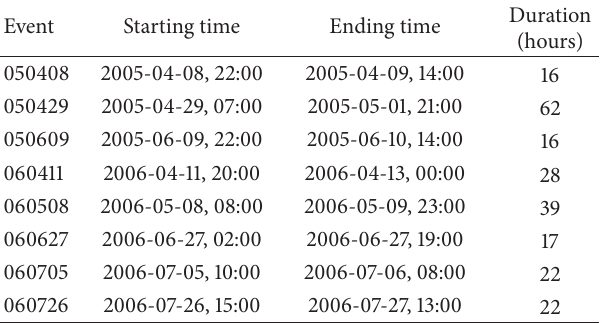
Table 1: Timing of the eight rainstorms chosen for the